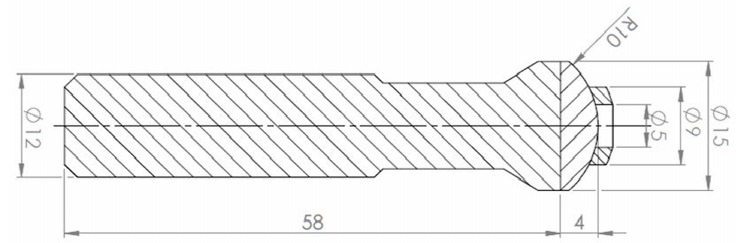
Figure 8. VEH R10 tool optimized for laser rod 3D correction.